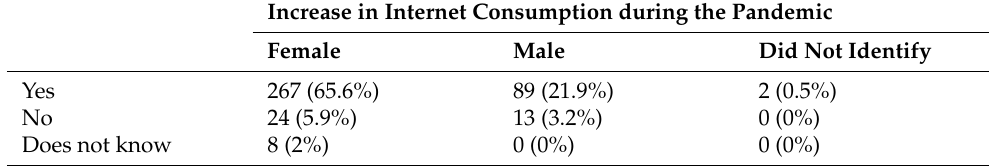
Table 4. Internet consumption, the pandemic, and internet dependency by gender.